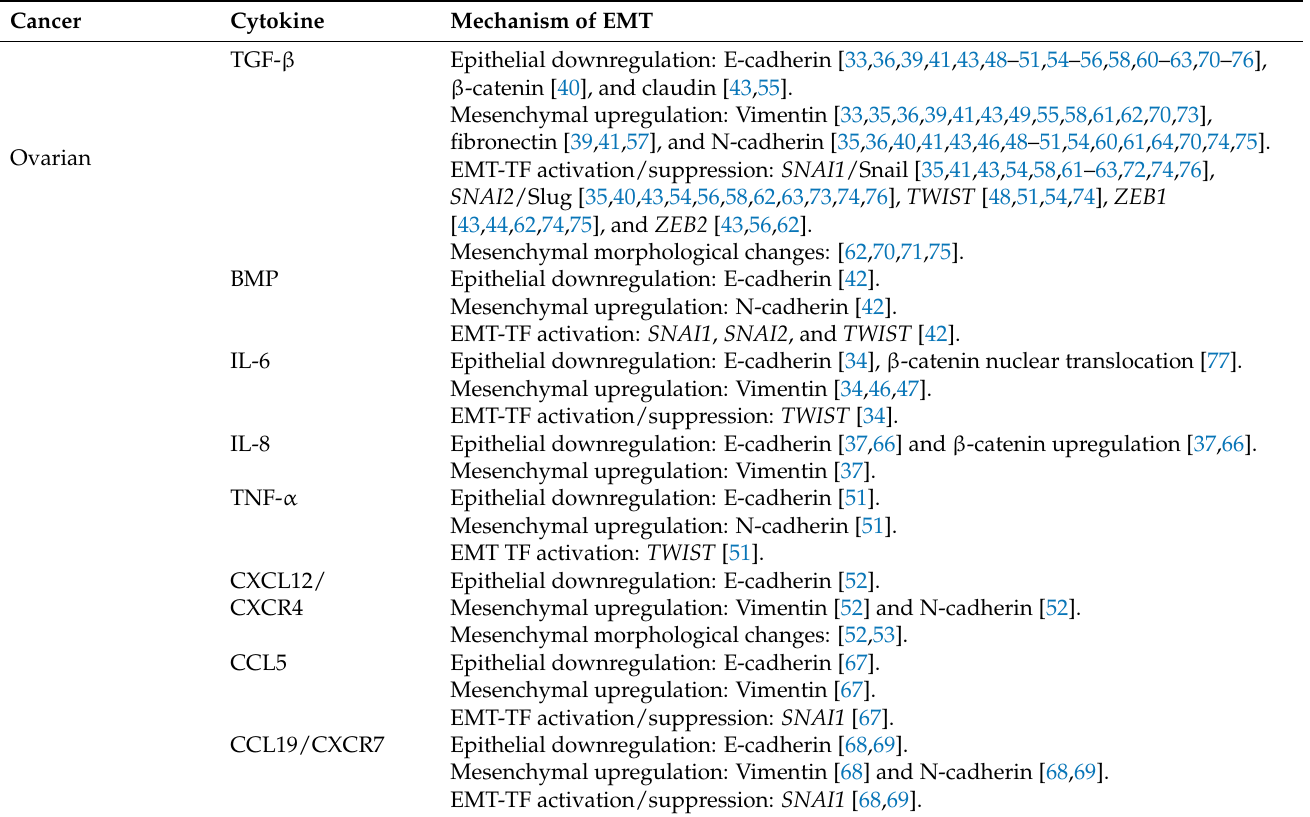
Table 2. EMT changes associated with cytokines/chemokines in ovarian